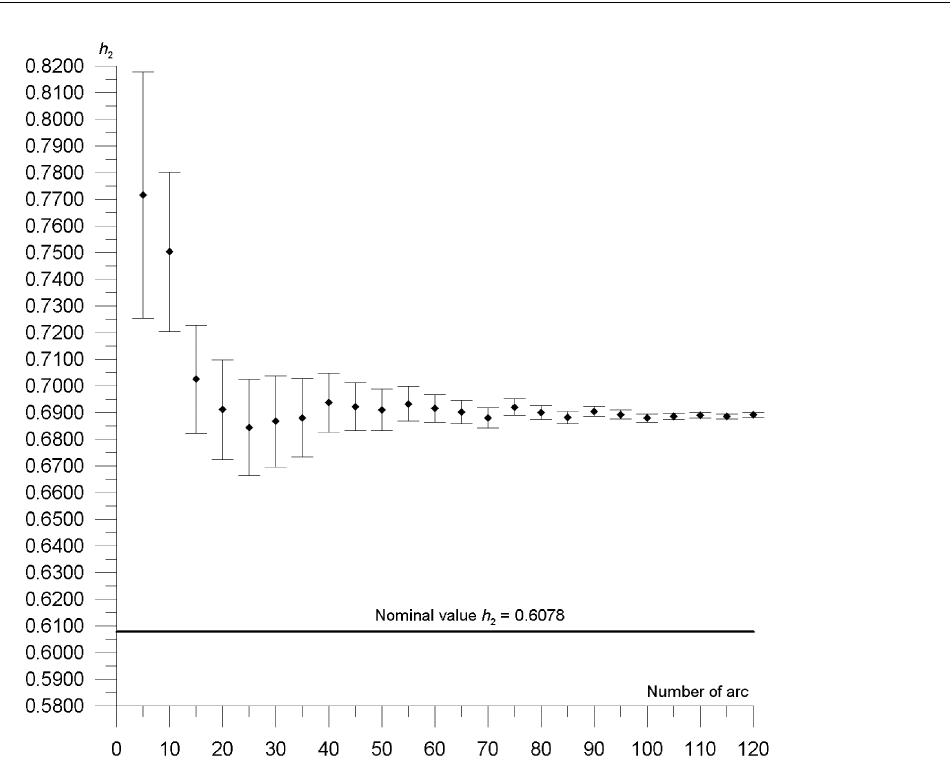
Fig. 1. The sequential solution for the local Love number h 2 for the Riga station estimated in the combined analysis based on data for LAGEOS-1 and LAGEOS-2. The final adjusted value (for 120 arcs) of the local Love number h 2 is 0.6891 ± 0.0009.